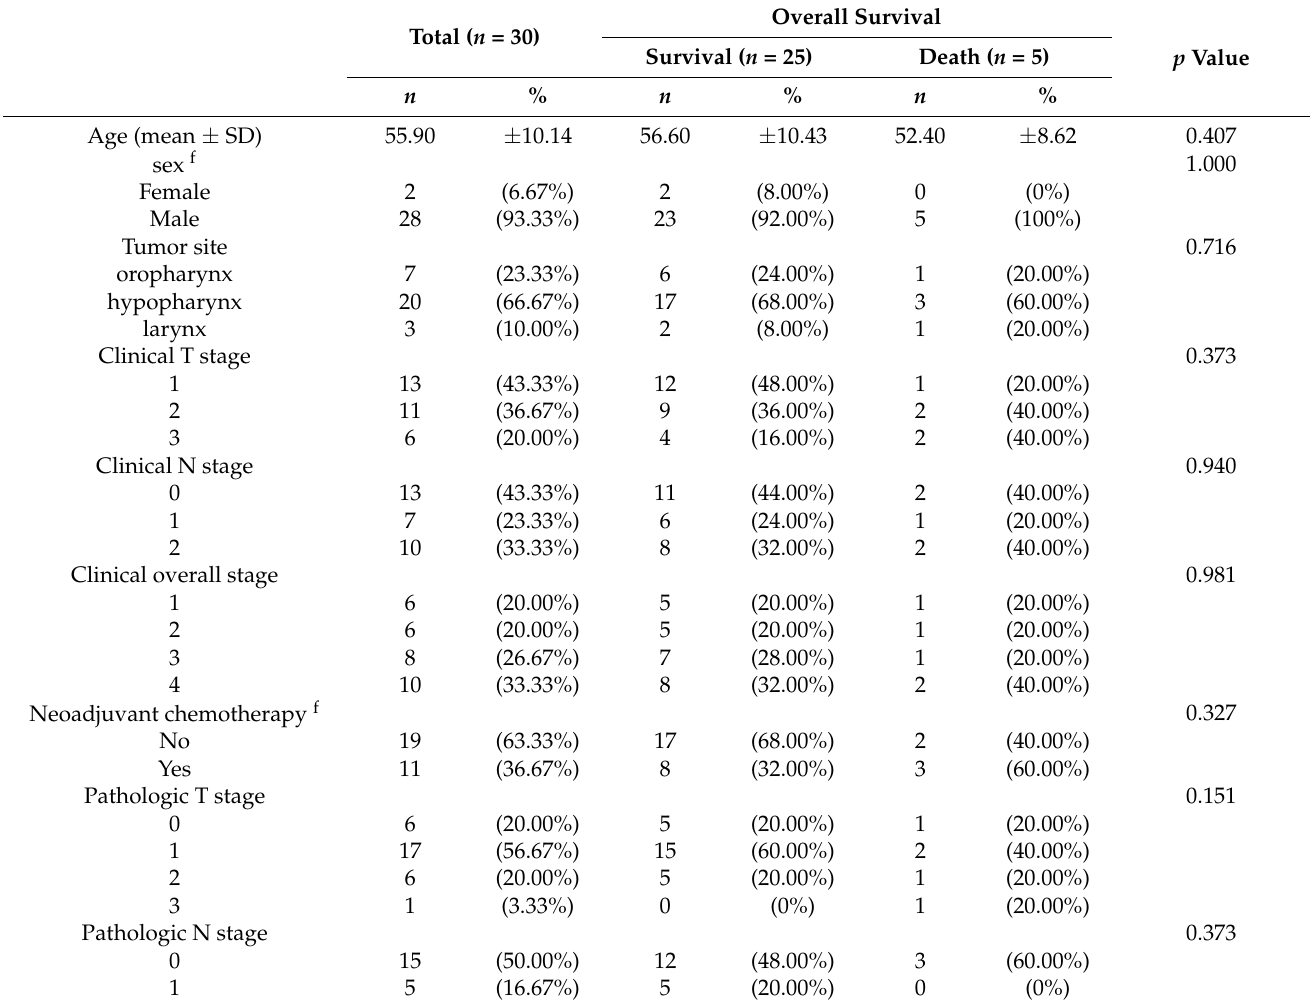
Table 1. The clinical factors and survival of 30 patients with pharyngeal and laryngeal cancers. Total ( n =